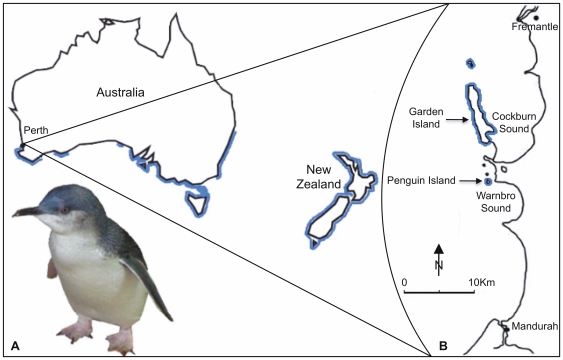

Eudyptula minor distribution and study site for faecal monitoring.(A) The costal distribution (marked in blue) of E. minor across Australia and New Zealand. (B) Map of the study site in Western Australia; for this faecal monitoring study samples were collected from Penguin Island.